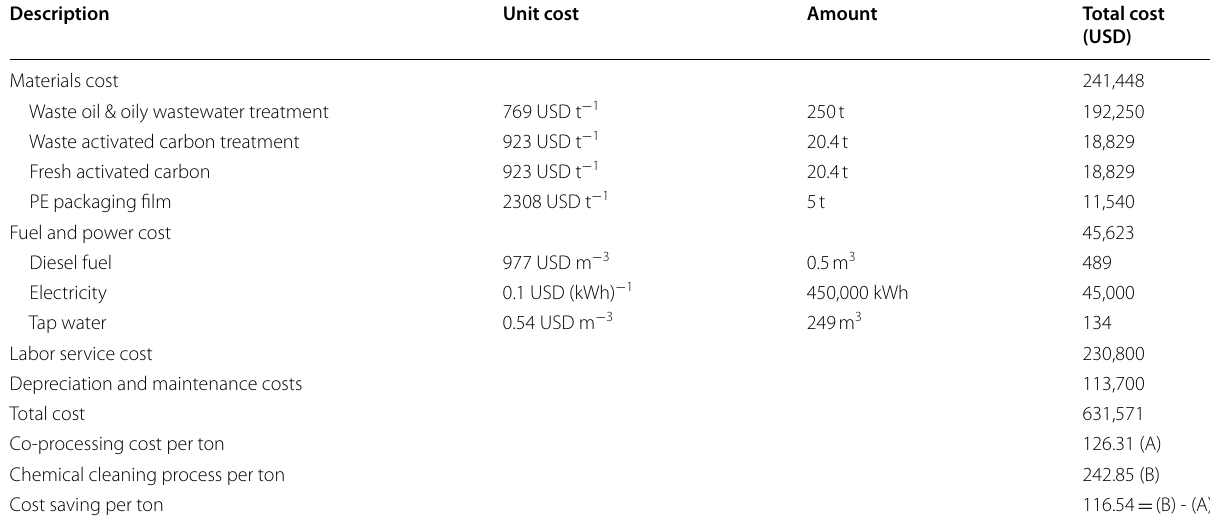
Table 6 Cost-effectiveness of converter co-processing technology